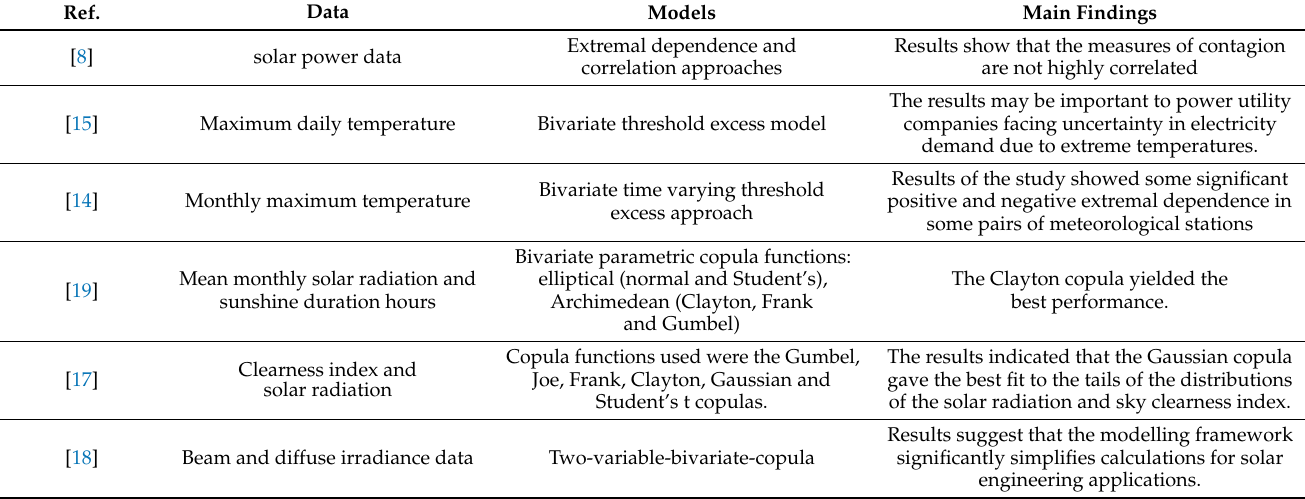
Table 1. Summary of previous studies on extremal dependence modelling of GHI with temperature.